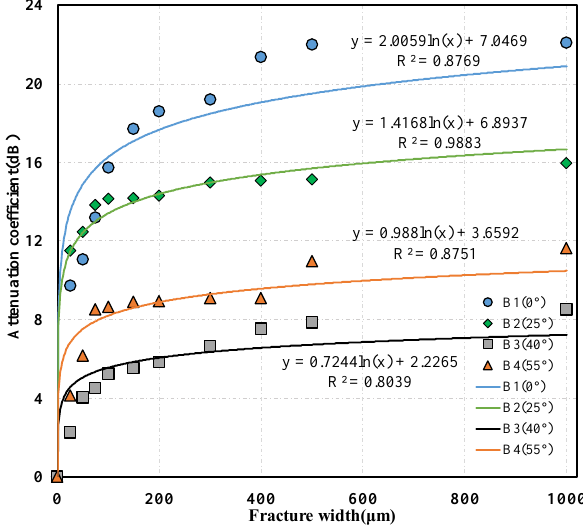
Figure 11. Relationship between shear wave attenuation coefficient and fracture width of the set of B cores containing fractures with different dip angles.